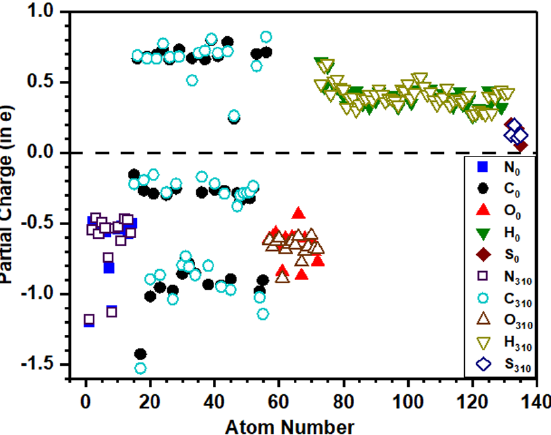
Figure 6. Calculated partial charge for each atom in dry 1FUV at 0 K and 310 K. (The subscripts 0 and 310 denote the temperature 0 K and 310 K, respectively).